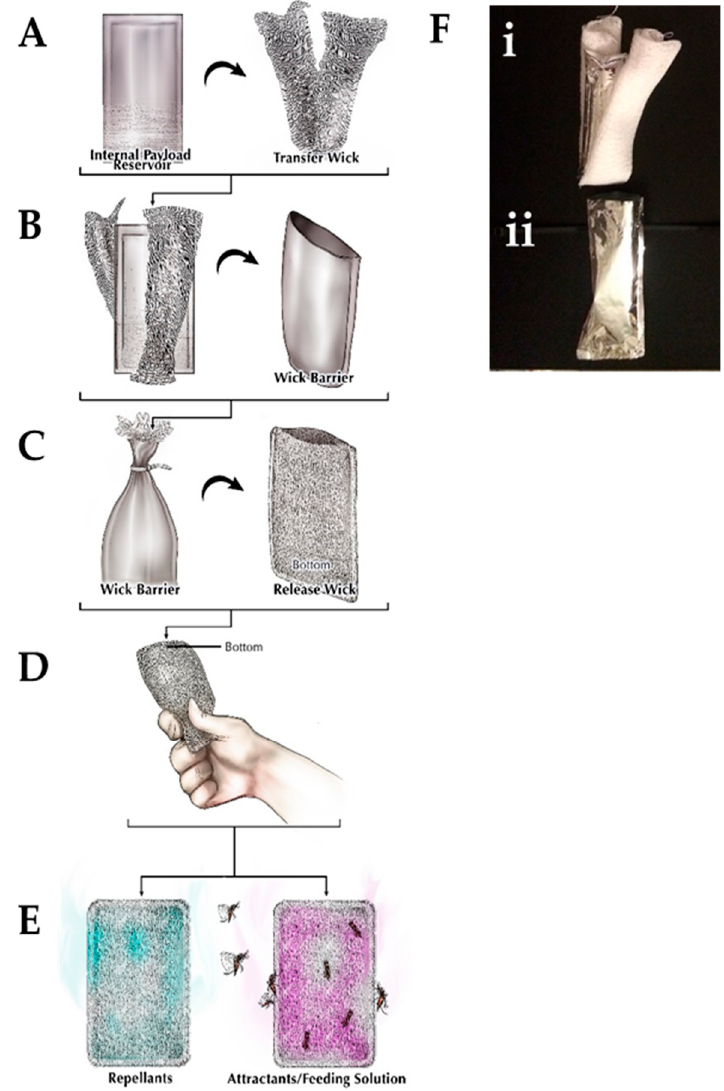
Figure 1. Controlled-release device. The ( A ) internal payload reservoir is surrounded by the transfer wick and they are placed together inside the ( B ) wick barrier. This wick barrier is placed inside the ( C ) release wick before being ( D ) utilized to ( E ) release either repellants or attractants / feeding solutions. ( F ) Actual images of the (i) internal reservoir and transfer wick that is inserted into the (ii) wick barrier.